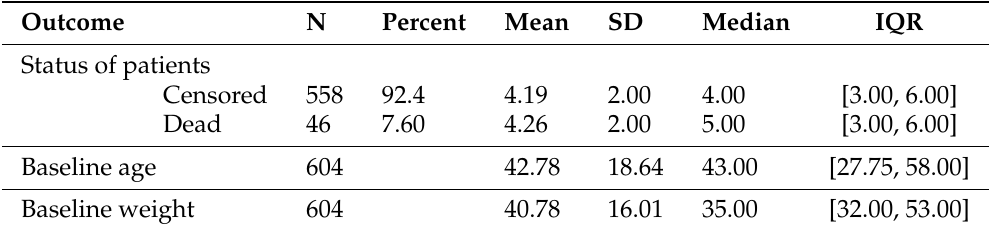
Table 2. Summary statistics of follow-up time in months and status of TB patients in randomly selected governmental hospitals in southwest Ethiopia.